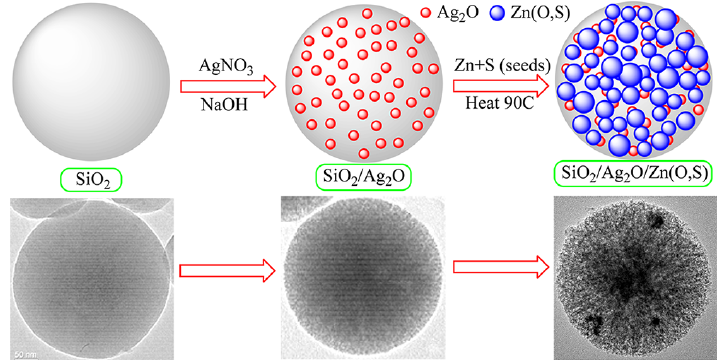
Figure 19. Schematic illustration for the synthesis of SiO 2 /Ag 2 O/Zn(O,S). Copyrights 2019 ACS [147].